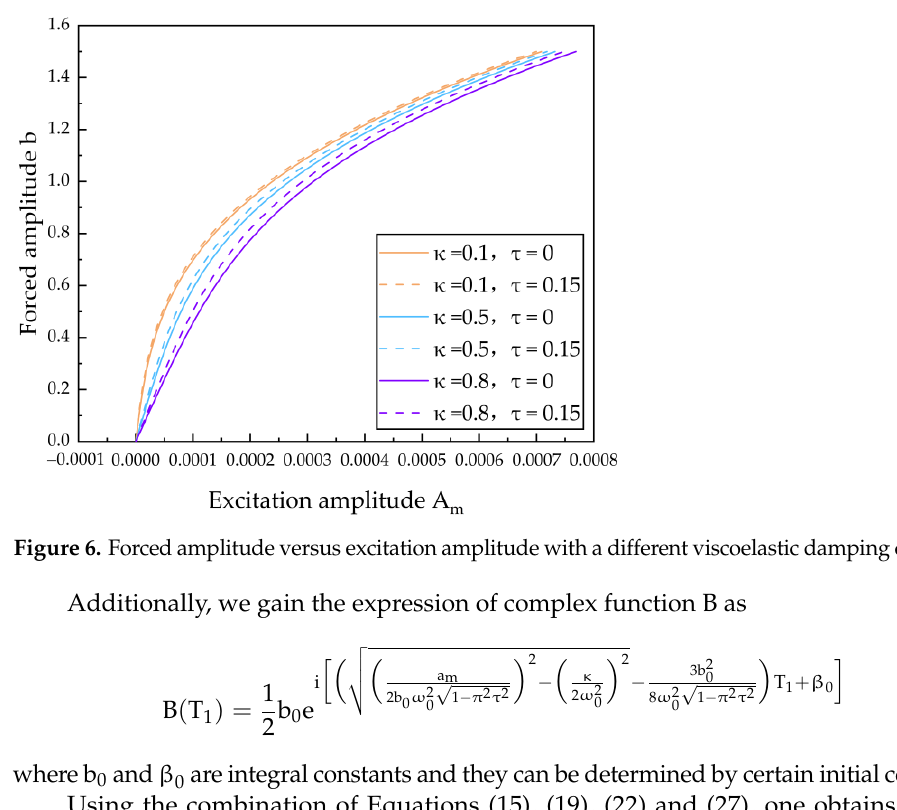
10 of 15 Figure 5. Forced amplitude versus excitation amplitude with different detuning parameters. Assuming = 0 ω 0 . 1 and